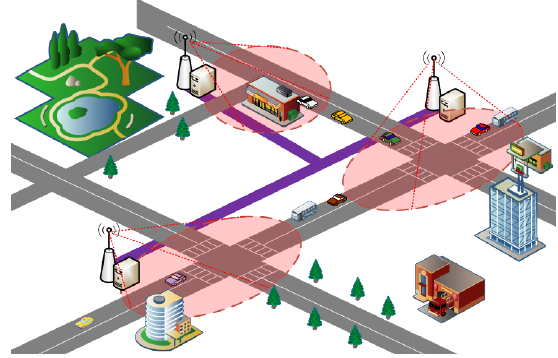
Sensors 2021 , 21 , x FOR PEER REVIEW Figure 1. Vehicular edge computing paradigm. Figure 1. Vehicular edge computing paradigm.